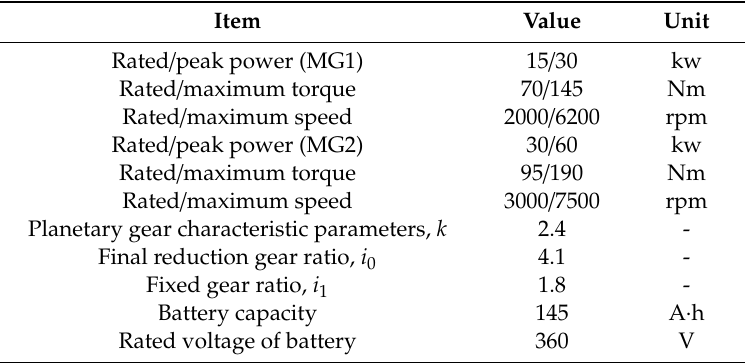
Table 6. Vehicle